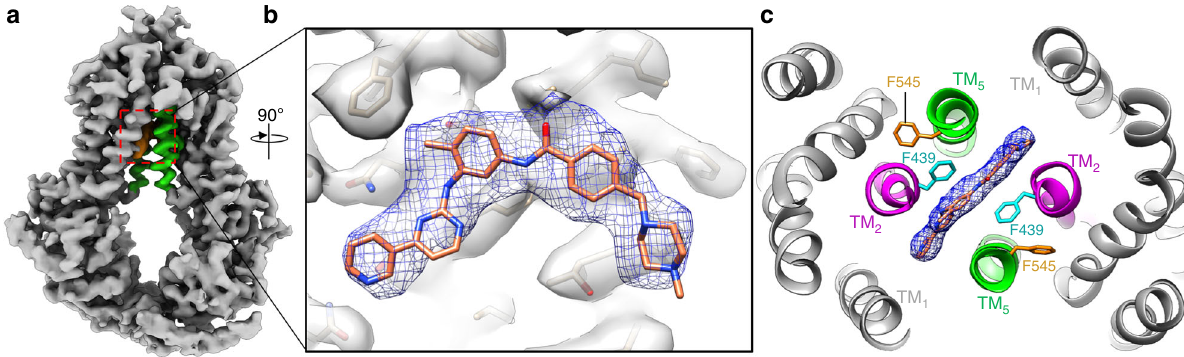
Fig. 3 Imatinib traps ABCG2 in an inward conformation. a Cryo-EM map of ABCG2 bound to imatinib. ABCG2 is in an inward facing conformation. TM5 is colored green, and imatinib is colored orange. Red dashed box indicates the position of bound imatinib. b Zoomed-in and rotated view of the highlighted area in ( a ) showing the cryo-EM map for imatinib. c View of the imatinib binding pocket from the extracellular space. Imatinib binds on the 2-fold axis between ABCG2 monomers and is sandwiched between Phe439 sidechains from